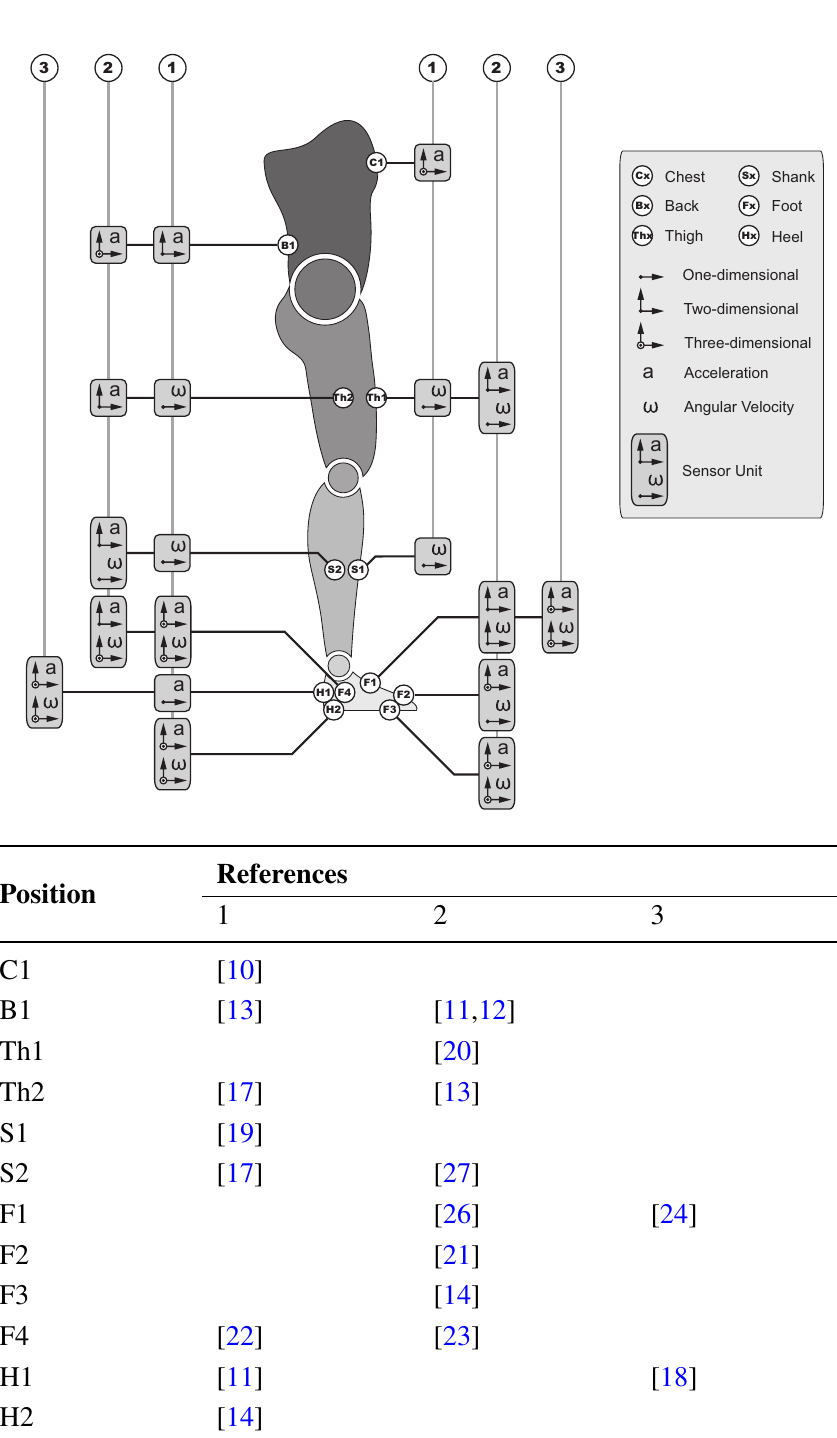
Table 2. Sensor Type and Attachment Position. In total, nine different types of inertial sensors, including uniaxial, biaxial and triaxial accelerometer and gyroscope, were attached to 12 positions, including the chest, back of the trunk, thigh, shank and